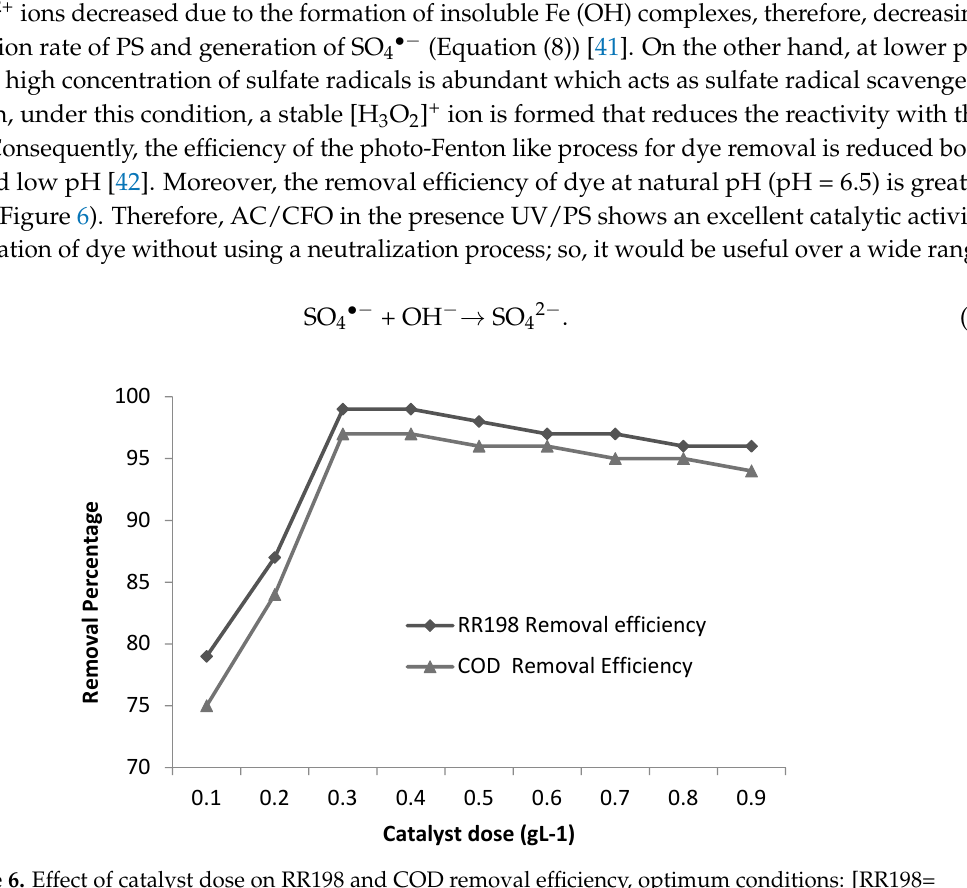
Figure 6. Effect of catalyst dose on RR198 and COD removal efficiency, optimum conditions: [RR198= 25 mg/L, PS = 5 mM/L, reaction time: 25 min, and pH= 6.5].